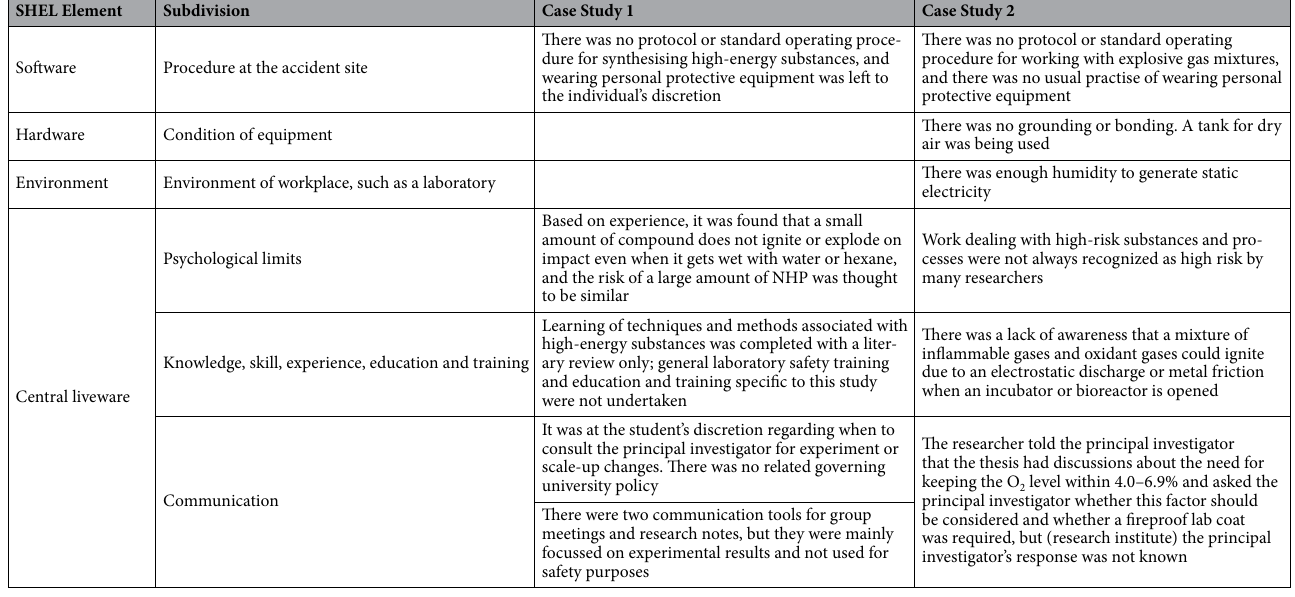
Table 2. Local workplace